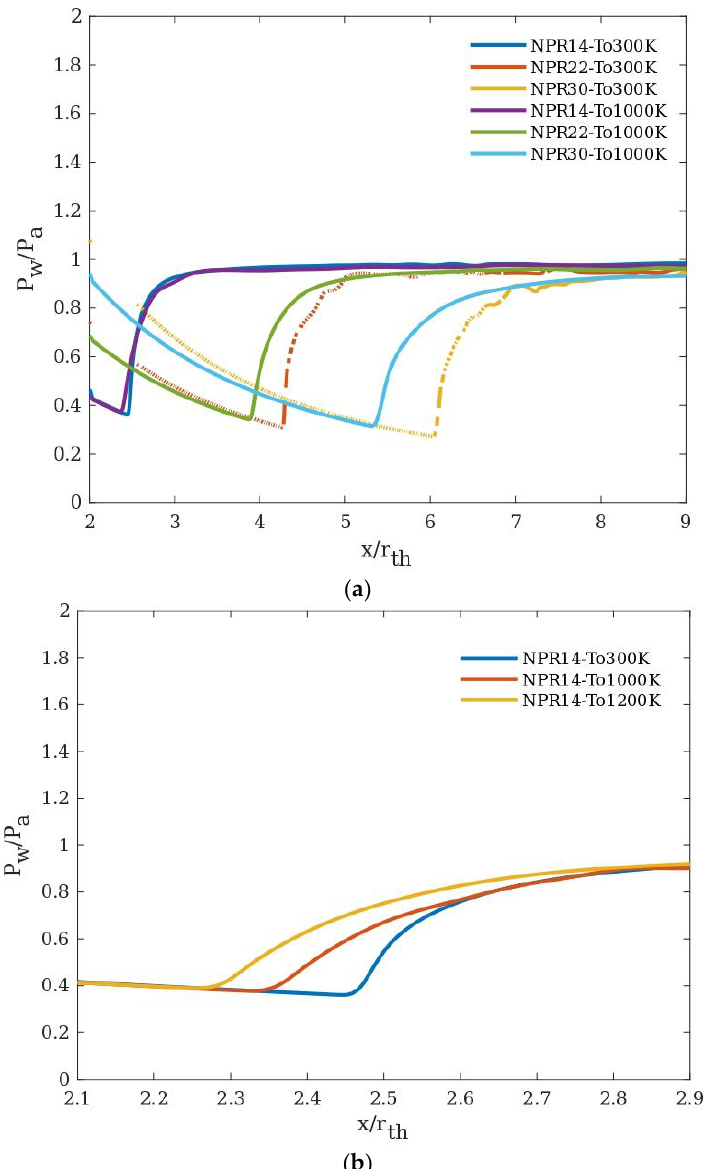
Figure 7. Wall pressure distribution for different inlet temperatures at ( a ) different NPRs and ( b ) NPR 14.